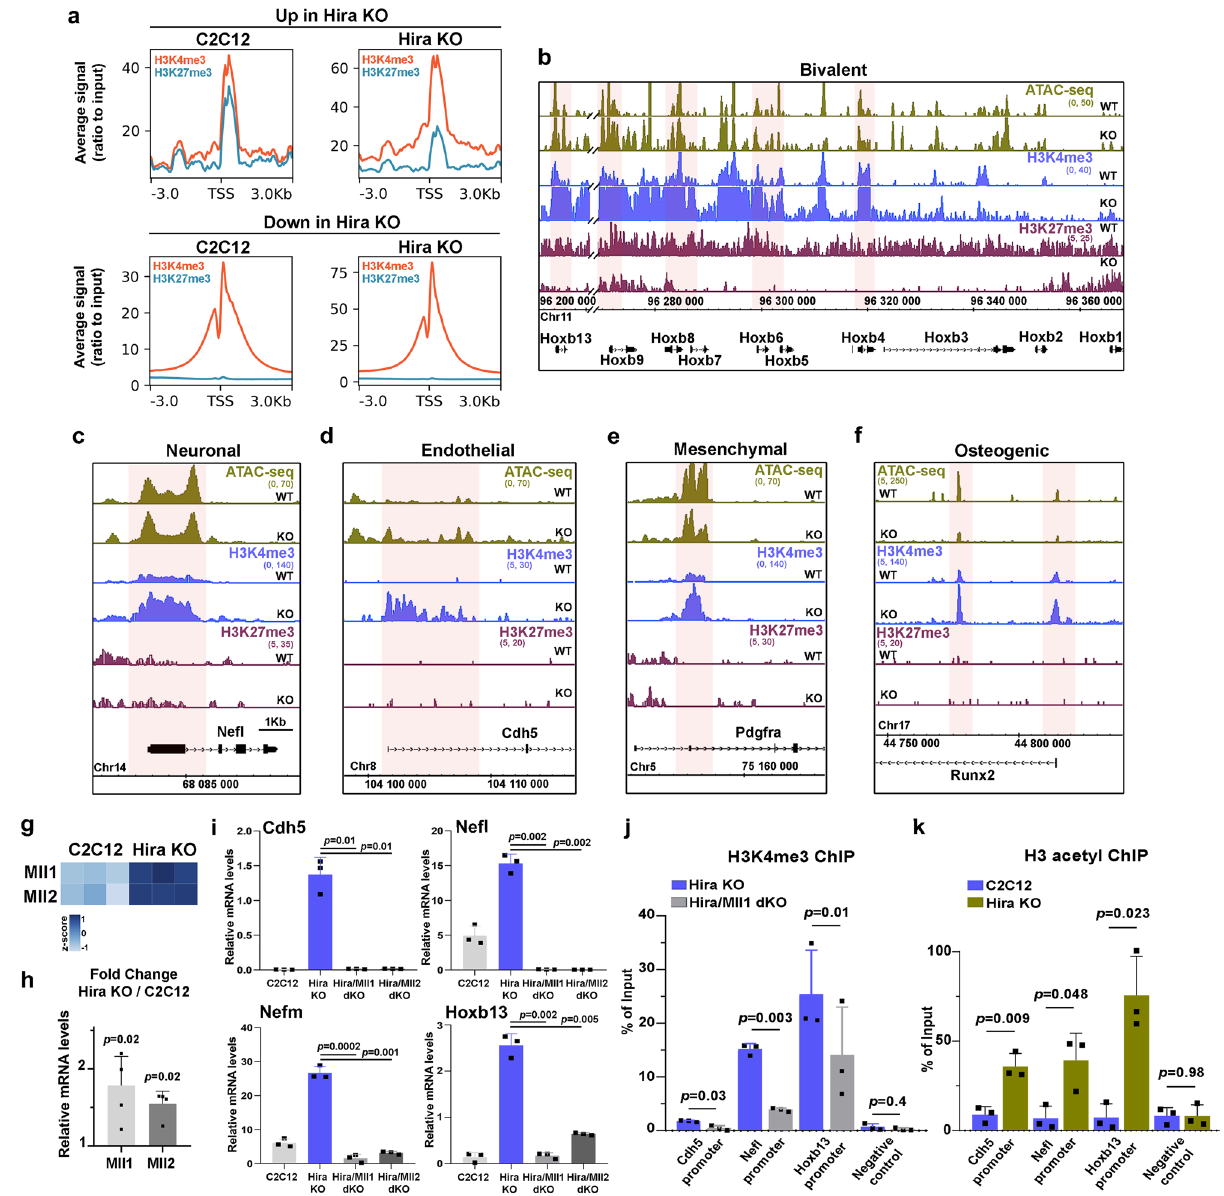
the promoter region (±3kb around the TSS) and TSS for H3K4me3 and H3K27me3 in C2C12 and Hira KO, plotted with the upregulated or the